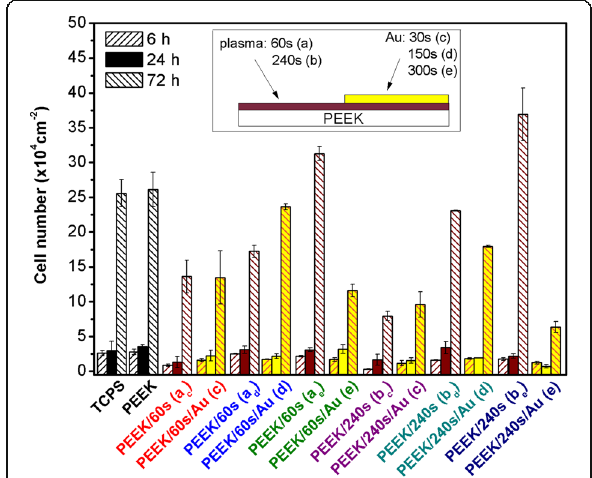
Fig. 3 Number of L929 cells after 6, 24, and 72 h of cultivation on TCPS, pristine PEEK, and PEEK with gold interfaces of plasma-treated (60 and 240 s) and Au-sputtered (30, 150, and 300 s) regions